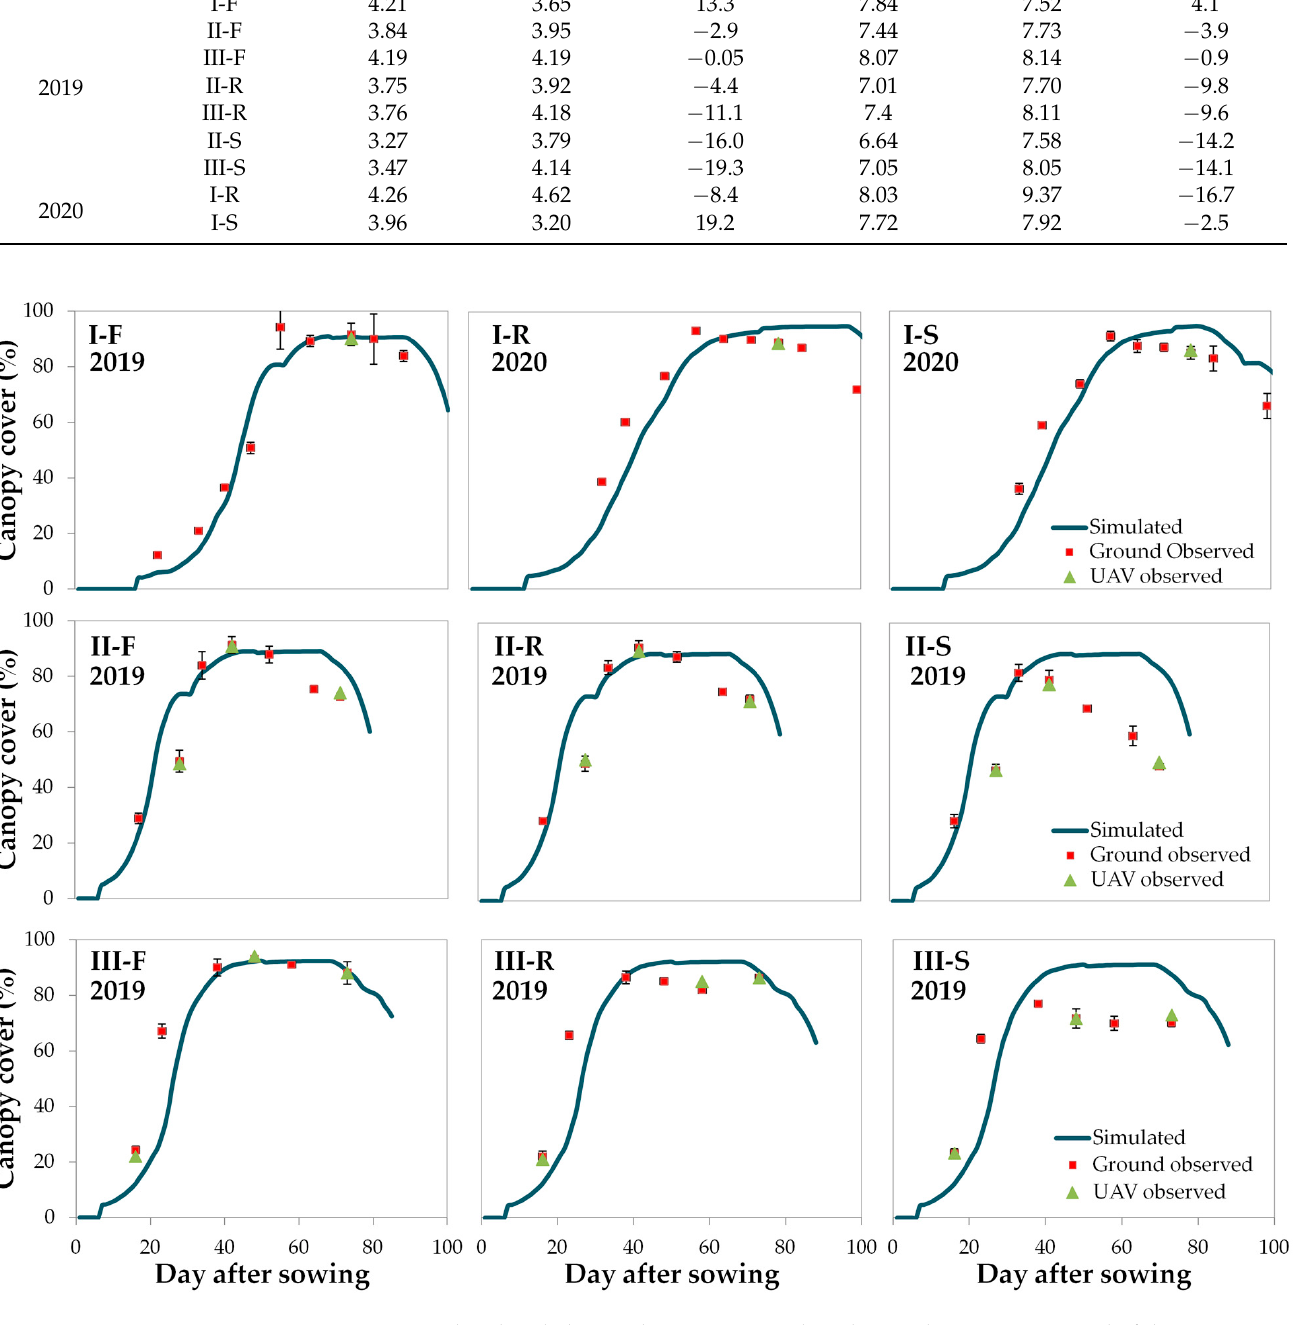
Figure 2. Simulated and observed canopy cover data during the growing period of the treatments used for model validation; full (F) and deficit (R and S) irrigation treatments and sowing periods I (spring), II (late spring), and III (summer).